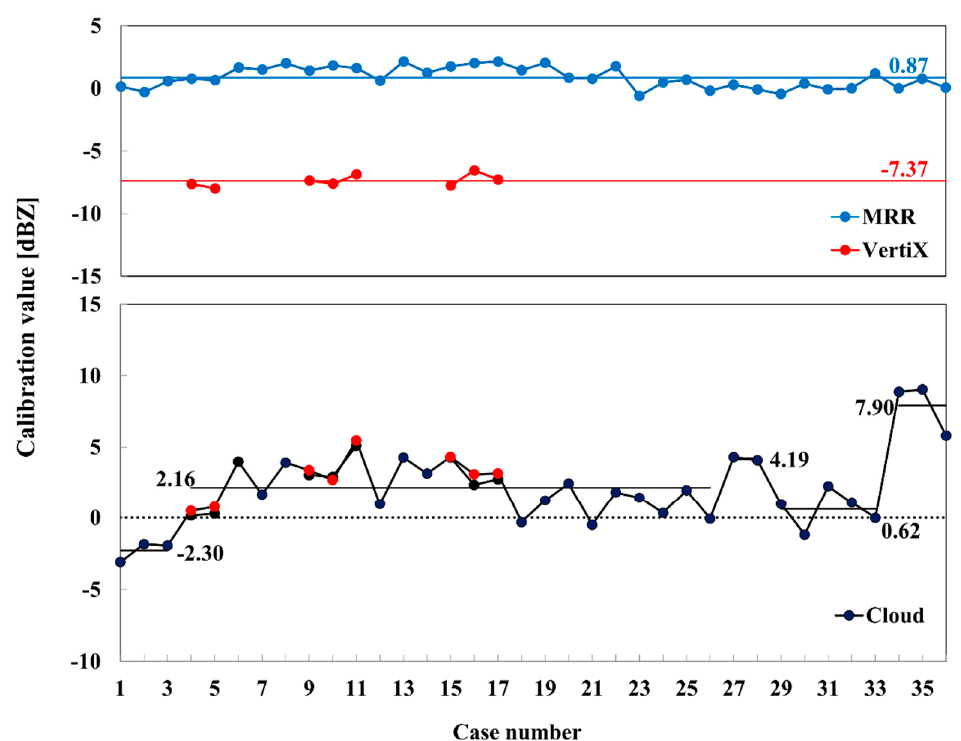
Figure 7. The calibration values of radar reflectivity from the three instruments during 36 rain events. Upper panel: MRR (blue) and VertiX (red); lower panel: cloud radar (black with MRR and red with VertiX).